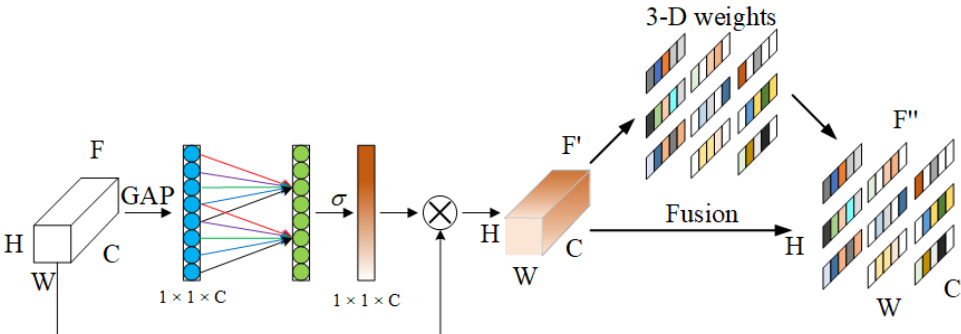
Figure 7. ECA-SimAM attention module.